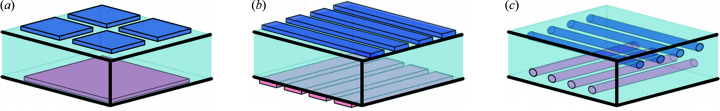
Sketch (not to scale) illustrating different detector electrode designs that are currently in use (a, b), and the electrode design presented in this paper (c).